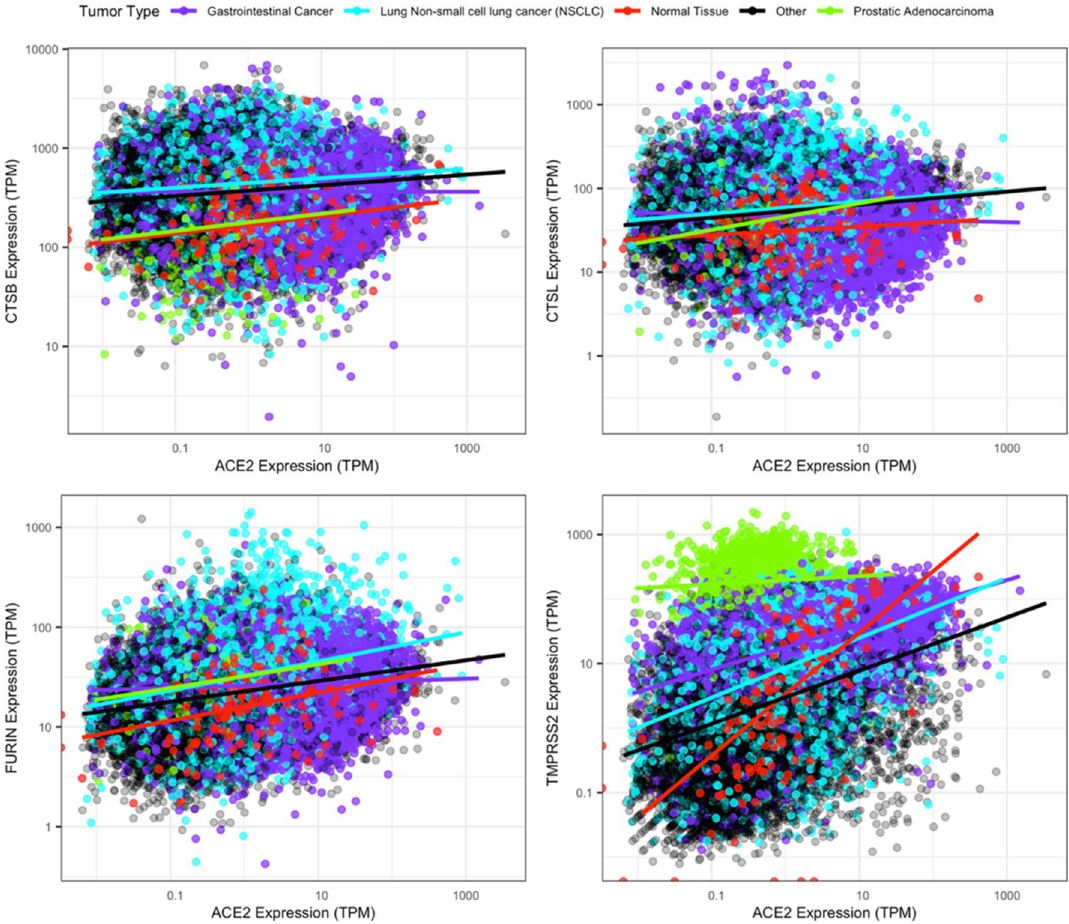
Figure 3. Co-expression of ACE2 and protease genes in normal and cancerous tissues. Data points are color- coded for normal (red), gastrointestinal cancers (purple), NSCLC (cyan), prostate cancer (green), and all other cancer types (black). Regression lines represent log-transformed